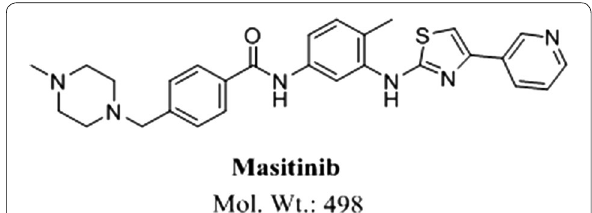
Fig. 1 Chemical structure of MST